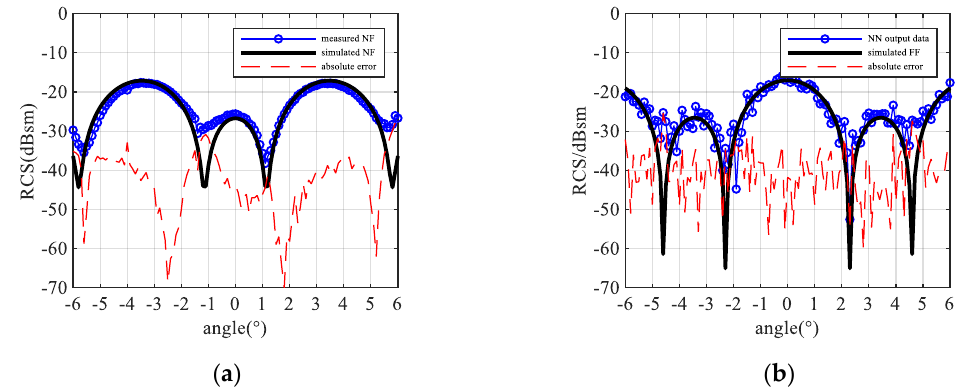
Figure 13. Sphere diameter = 45 mm (1.5λ), R = 0.125 m (4.16λ) result: ( a ) near-field measurement result and absolute error; ( b ) NN output result and absolute error.